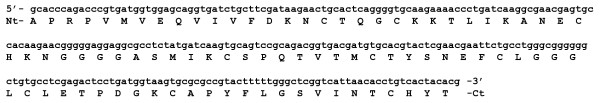
Nucleotide (above) and amino acid (below) sequences of the COOH-terminal extension from L. (L.) amazonensis CPB. Sequences are informed as 5' → 3' and NH3-terminal (Nt) → COOH-terminal (Ct), respectively.